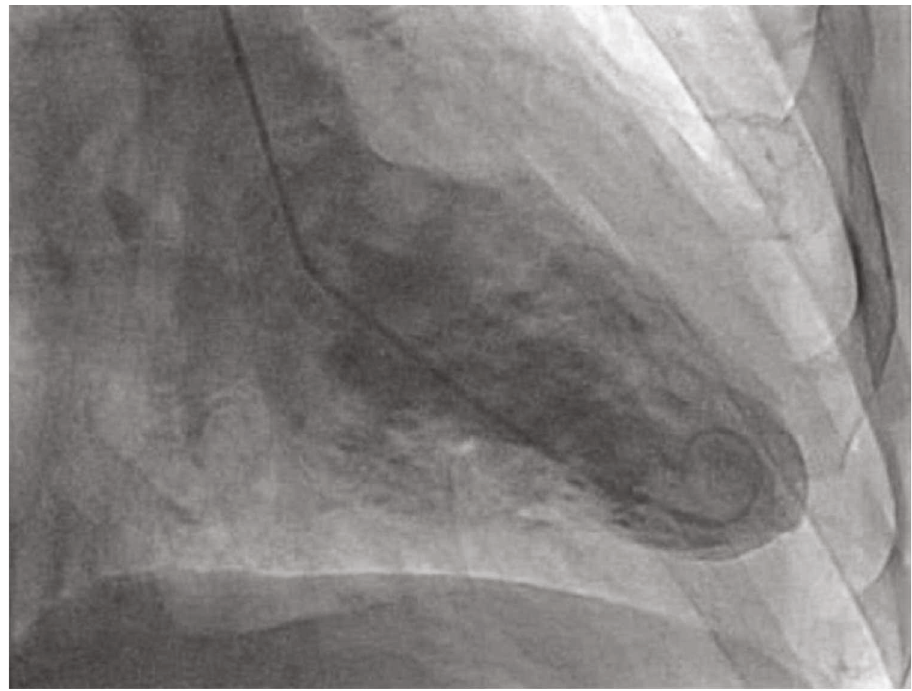
Figure 4: Left ventriculogram revealing a mildly reduced ejection fraction (visual estimation of 40%) along with akinesis of the distal anterior, apical anterior, and apical and apical inferior walls without evidence of an apical thrombus. Table 1: Criteria for diagnosis of coronary embolism (Shibata et